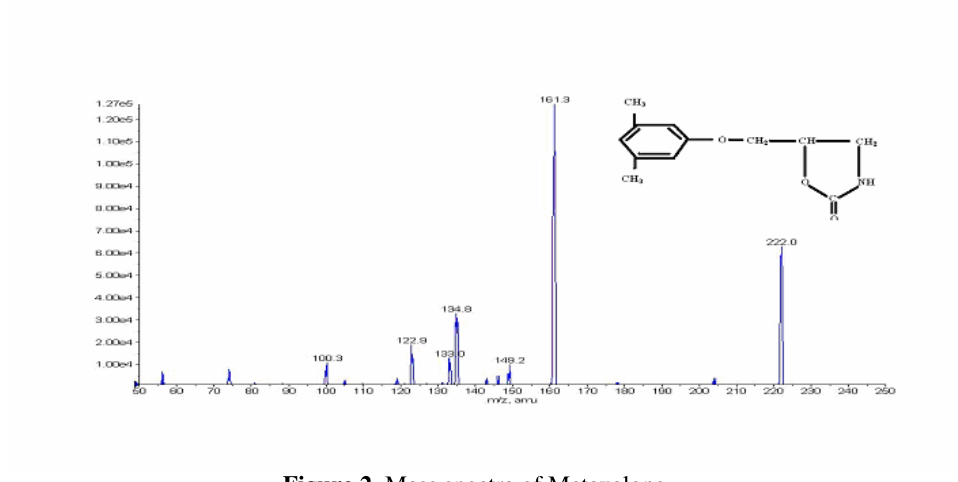
Figure 2 . Mass spectra of